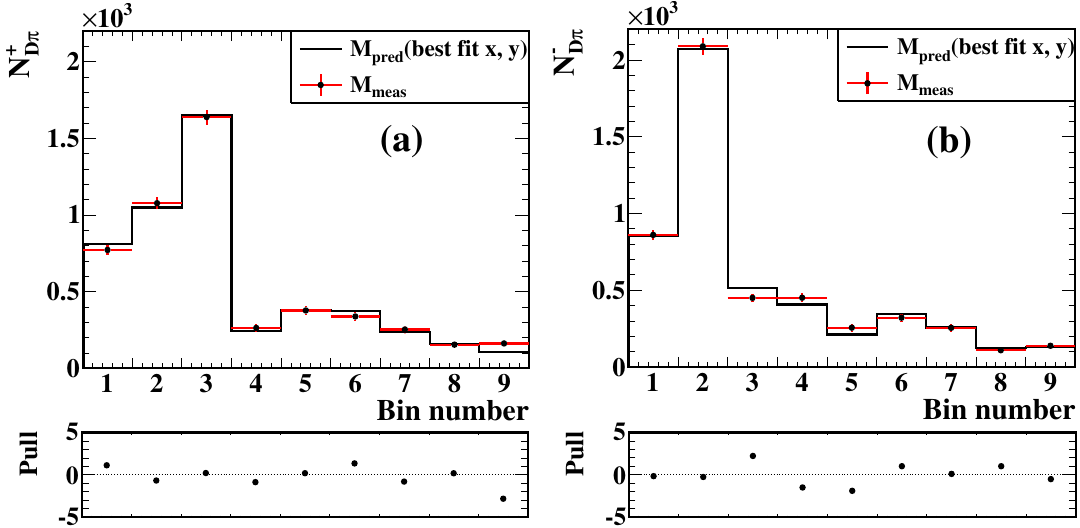
Figure 7 . Measured and expected yields in bins for (a) B + ! D(cid:25) + and (b) B (cid:0) ! D(cid:25) (cid:0) data samples. The data points with error bars are the measured yields, and the solid histogram is the expected yield from the best (cid:12)t ( x (cid:6) ; y (cid:6) ) parameter values.